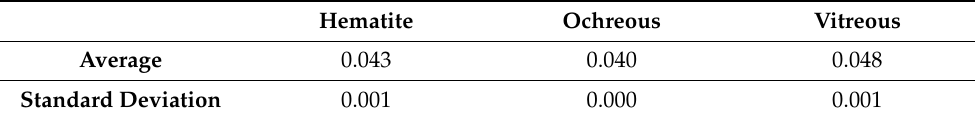
Table 3. The average RMSE modeling error and standard deviations for a repeated K-fold scenario comprised of 4 folds and 5 repeats where each repeat selects 5 different folds than those previously used. This is the equivalent of holding out 25% of the input features and mixing ratios in each fold and training with the remaining 75%. Hematite Ochreous 0.001 0.000 0.001